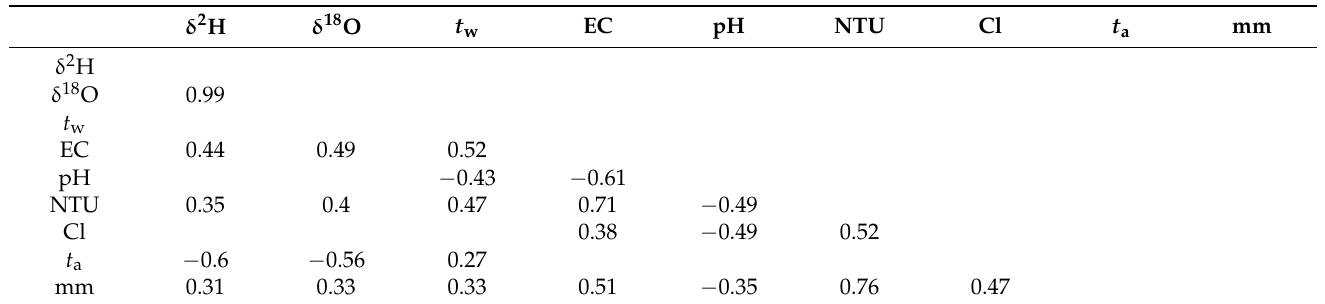
Table 5. Matrix of linear correlation coefficients between groundwater parameters of Martinš´cica well 2 (W2). Only statistically significant coefficients are given. t w —water temperature, EC—electrical conductivity, NTU—turbidity; Cl—chloride ion concentration; t a —average air temperature between two consecutive samplings; mm—total rainfall between two consecutive samplings.